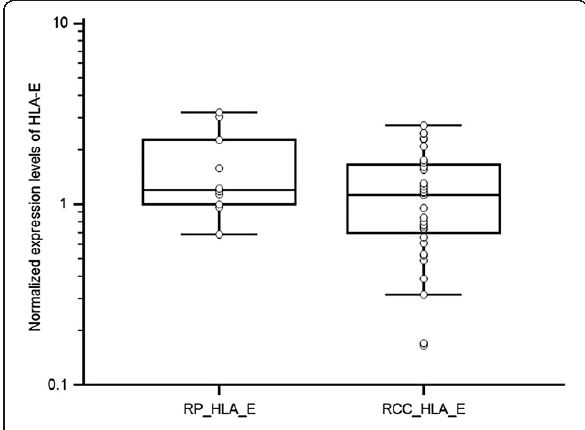
Figure 2 Comparison of HLA-E expression levels in RCC tissue and non-tumoral renal parenchyma (p=0.126, Mann – Whitney test).